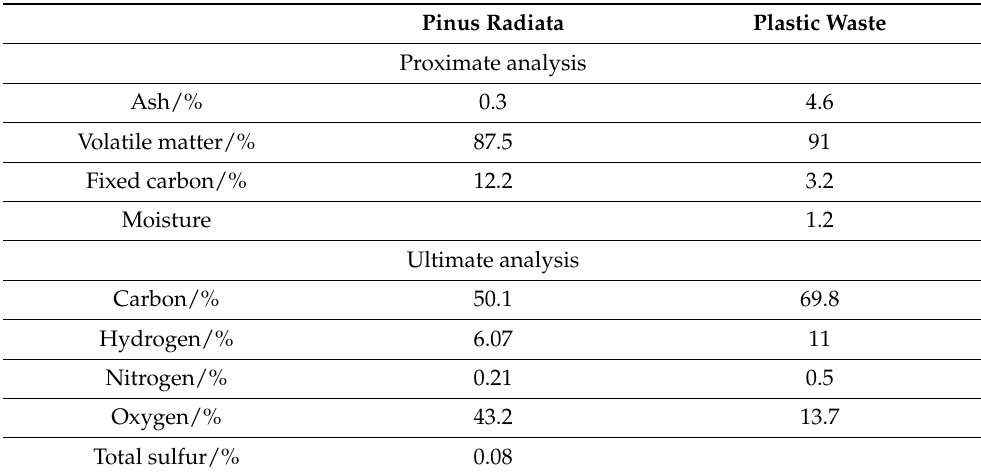
Table 3. Proximate and ultimate analysis of sawdust and plastic